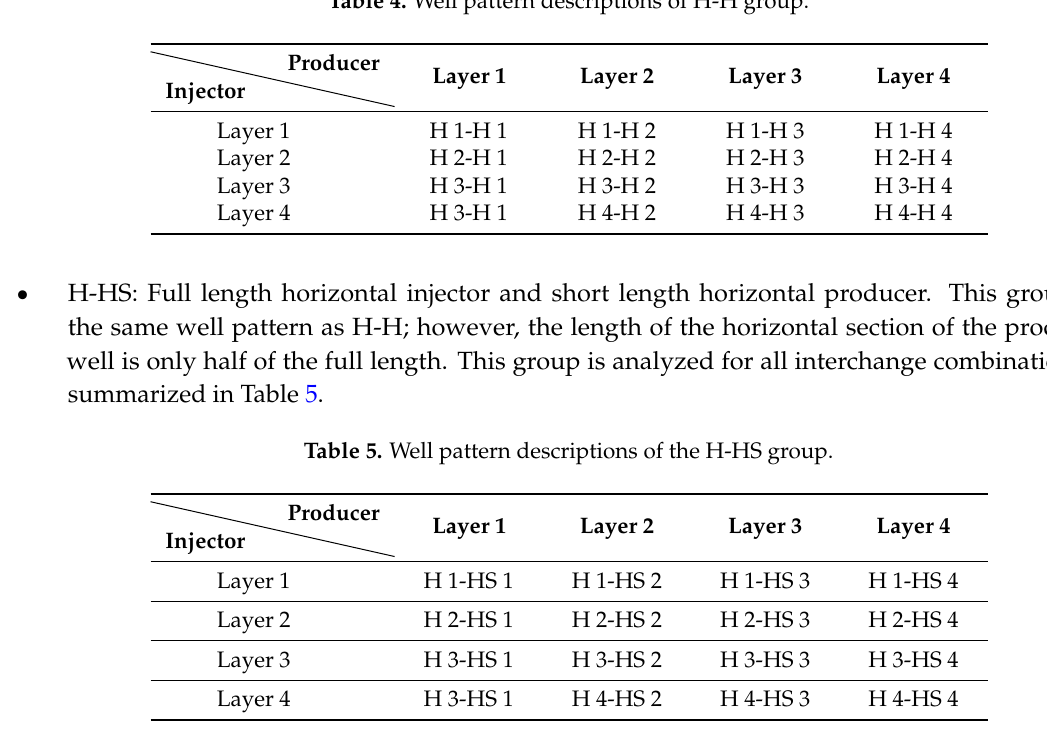
Table 4. Well pattern descriptions of H-H group.